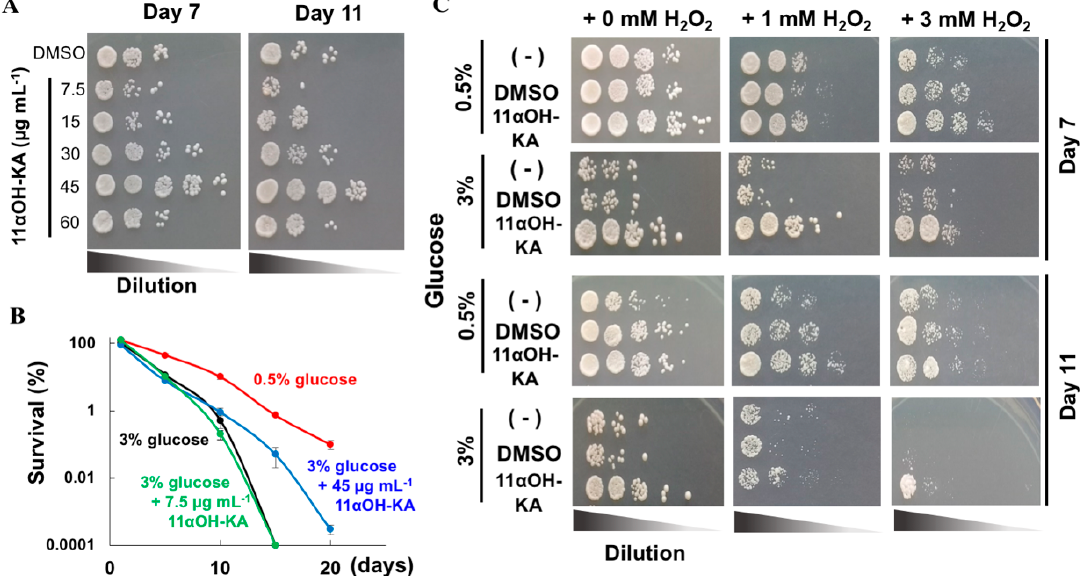
Figure 3. 11 α OH-KA promotes longevity in yeast. ( A ) Spot assay of S. pombe with various concentrations of 11 α OH-KA. ( B ) Colony-forming units (CFU) were measured after the incubation of the yeast with 11 α OH-KA. Data are normalized by the values of DMSO control at day 1 (stationary phase). The y-axis is shown in logarithmic scale. Yeasts were cultured in YES liquid medium containing either 0.5% glucose with DMSO (red) or 3% glucose with DMSO (black), 11 α OH-KA (45 µg mL − 1 : blue), or 11 α OH-KA (7.5 µg mL − 1 : green) n = 3. ( C ) The yeast cells were preincubated in YES liquid medium containing DMSO or 11 α OH-KA treatment (45 µg mL − 1 ) with glucose (0.5% or 3%). Mild oxidative stress was induced by the addition of H 2 O 2 (1 mM or 3 mM).